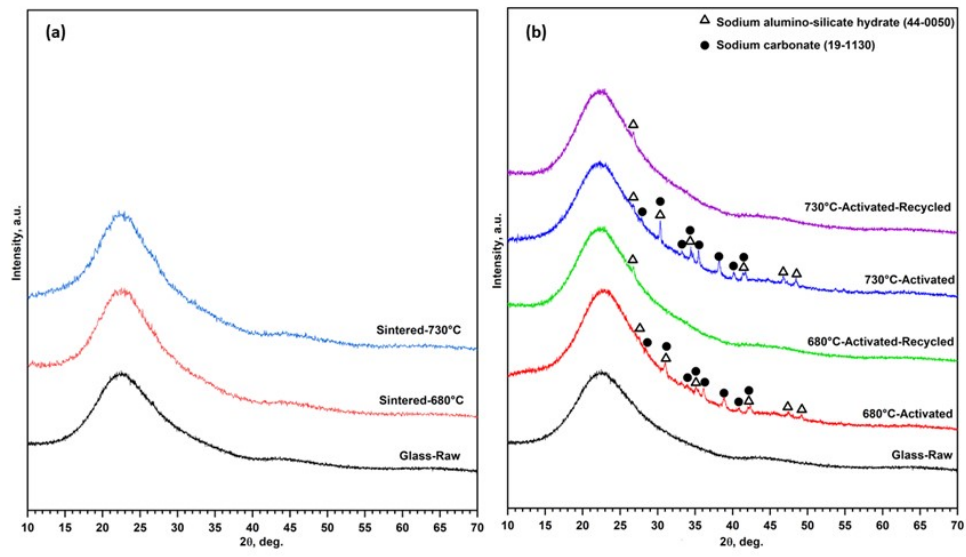
Figure 3. ( a ) XRD of glass sintered at 680 and 730 °C; ( b ) XRD of activated and recycled activated glass sintered at 680 and 730 °C.